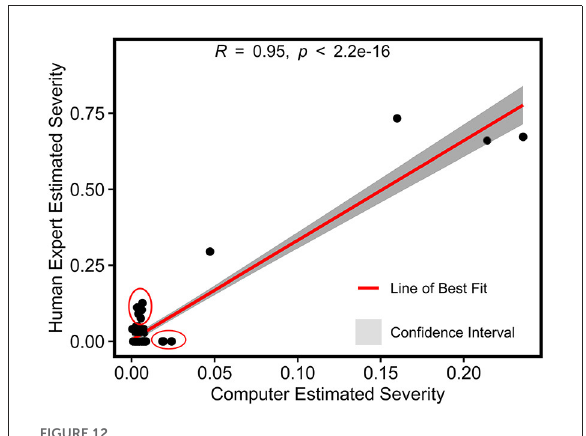
FIGURE12 Pearson’s correlation result of normalized severity rates of PM fungicide efficacy test calculated using the imaging-based pipeline and human field assessment. Red circles represent outliers in the mildly infected